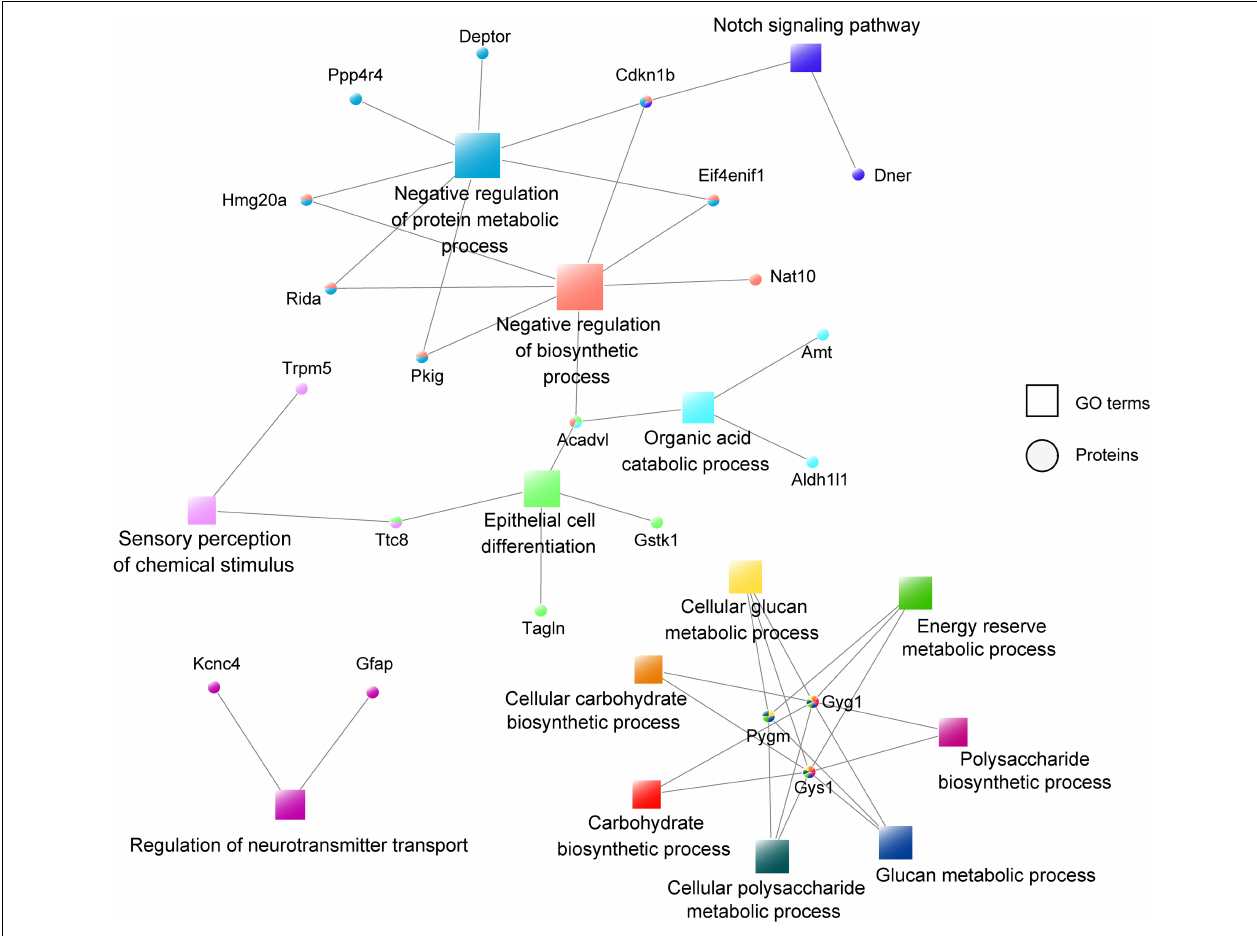
FIGURE 7 | Co-expression network of the differentially expressed proteins and their enriched GO terms. The circular nodes represent the proteins and the square nodes represent the GO